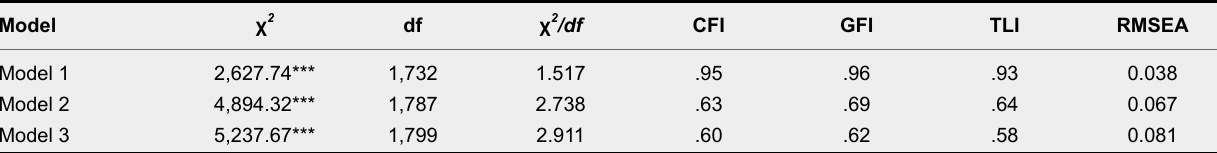
The Fit Indices for Alternative Measurement